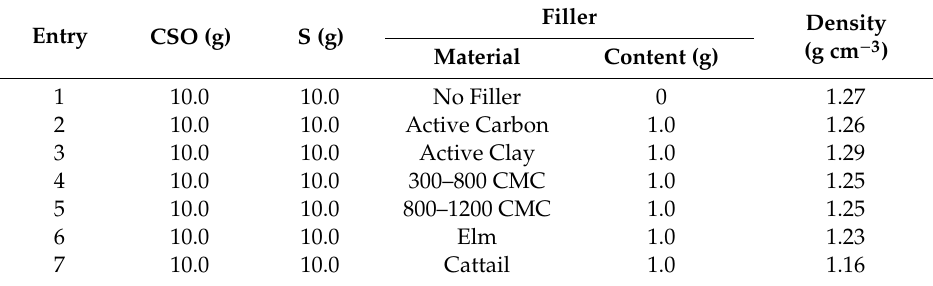
Table 2. E ff ect of fillers on the density of bio-based polysulfide Table 2. Effect of fillers on the density of bio-based polysulfide composites.